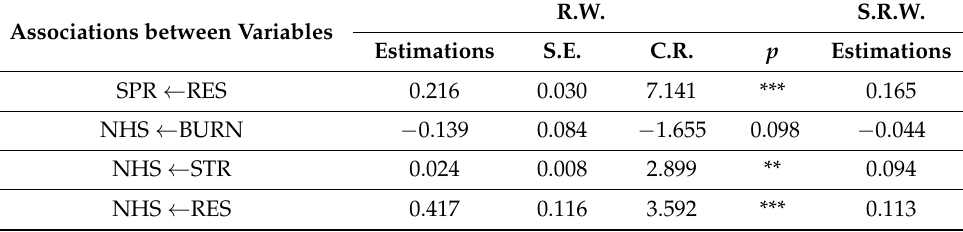
Table 3. Cont. Associations between